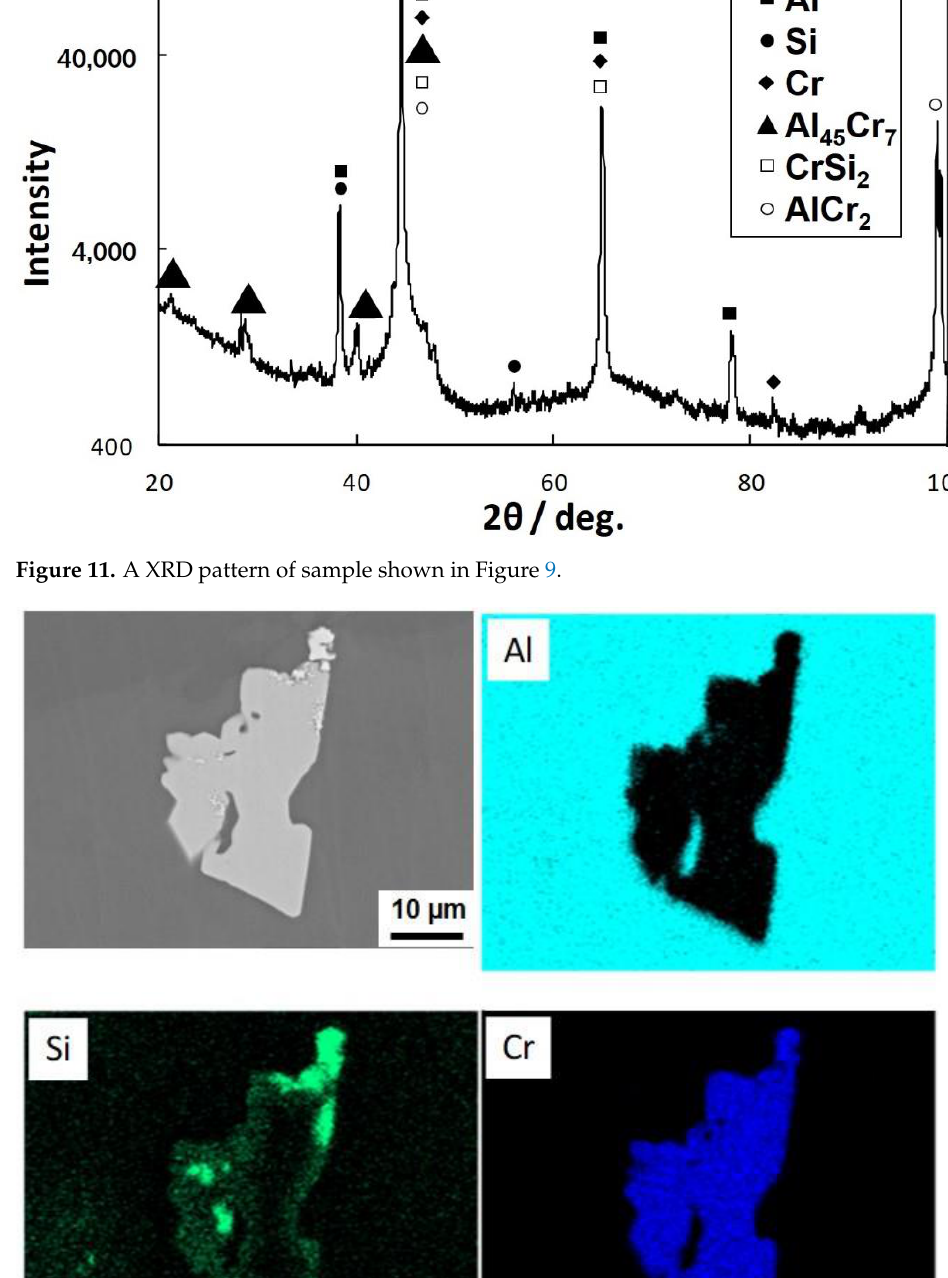
Figure 10. A SEM image of large Al-Cr compounds.